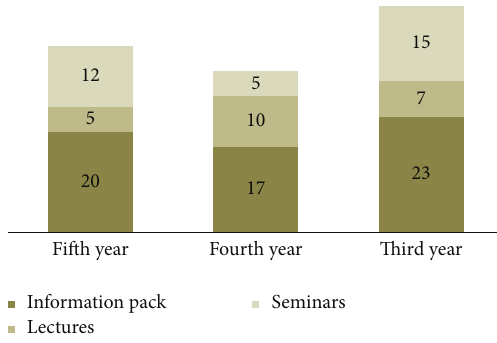
Figure 1: Students preferences for obtaining further information about oral cancer.